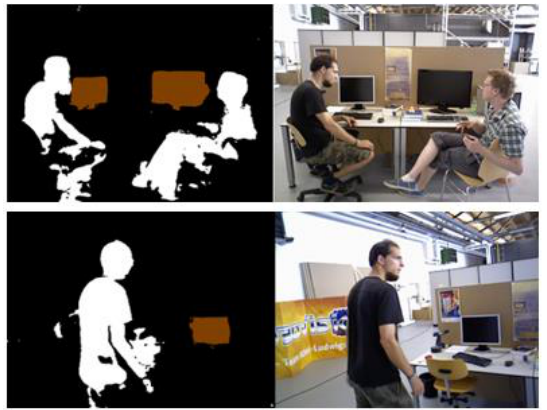
Figure 2. Semantic segmentation results